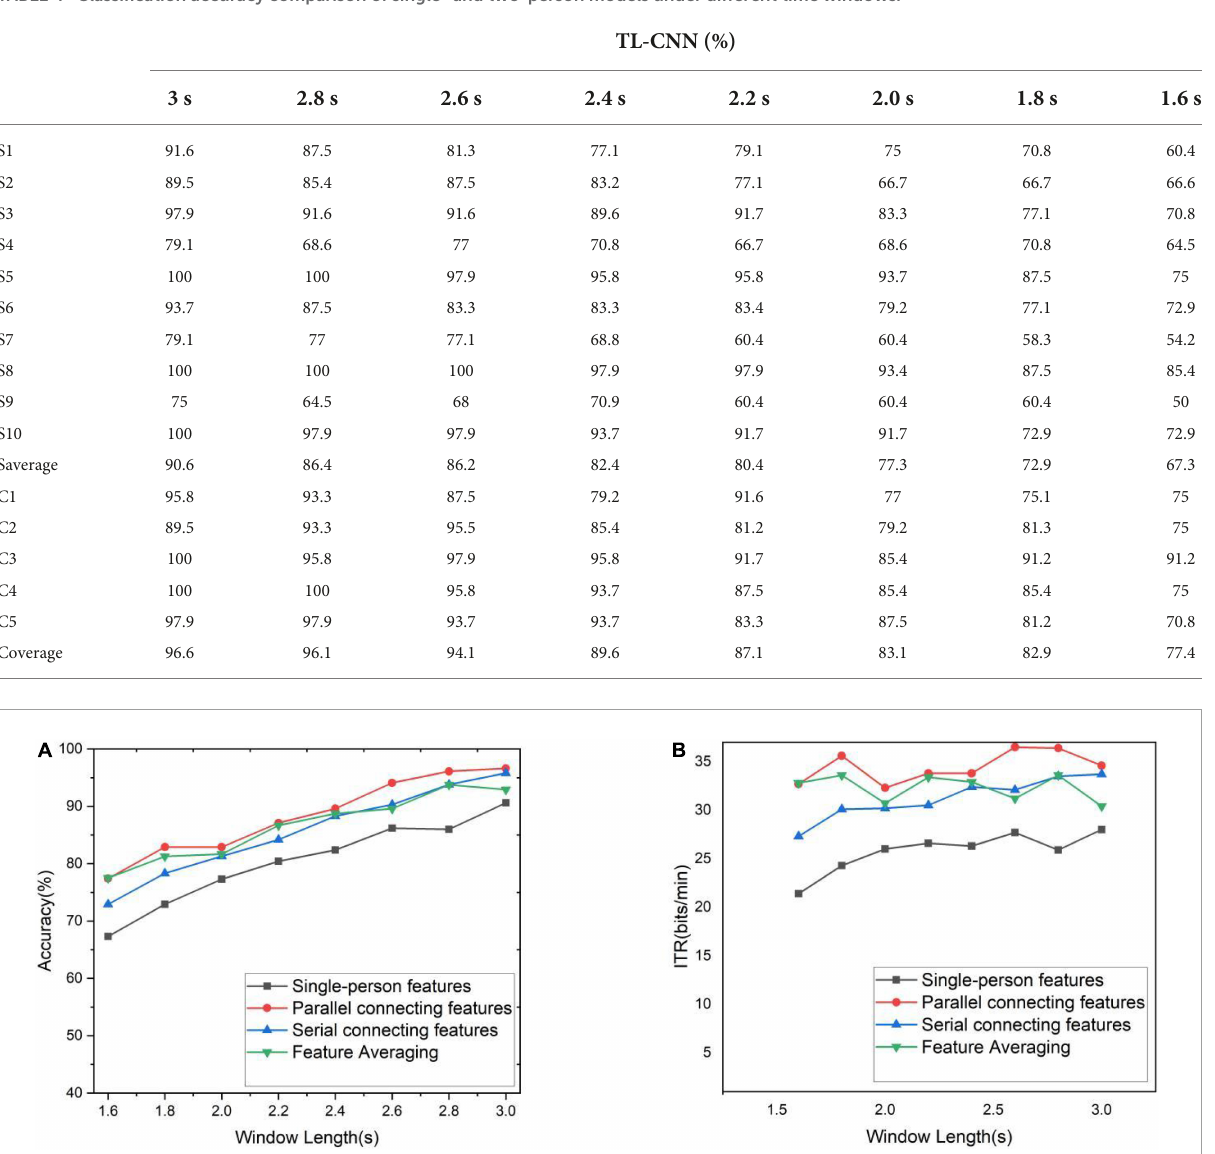
TABLE 4 Classification accuracy comparison of single- and two-person models under different time windows.